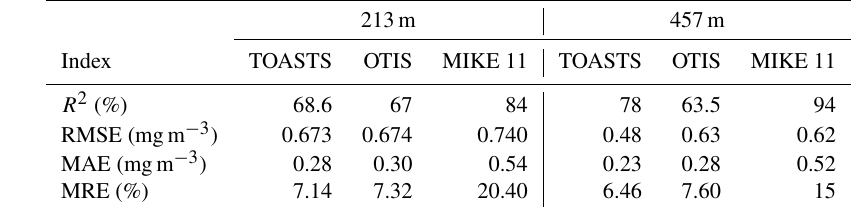
Table 16. Huey Creek experiment error indices (test case 6).